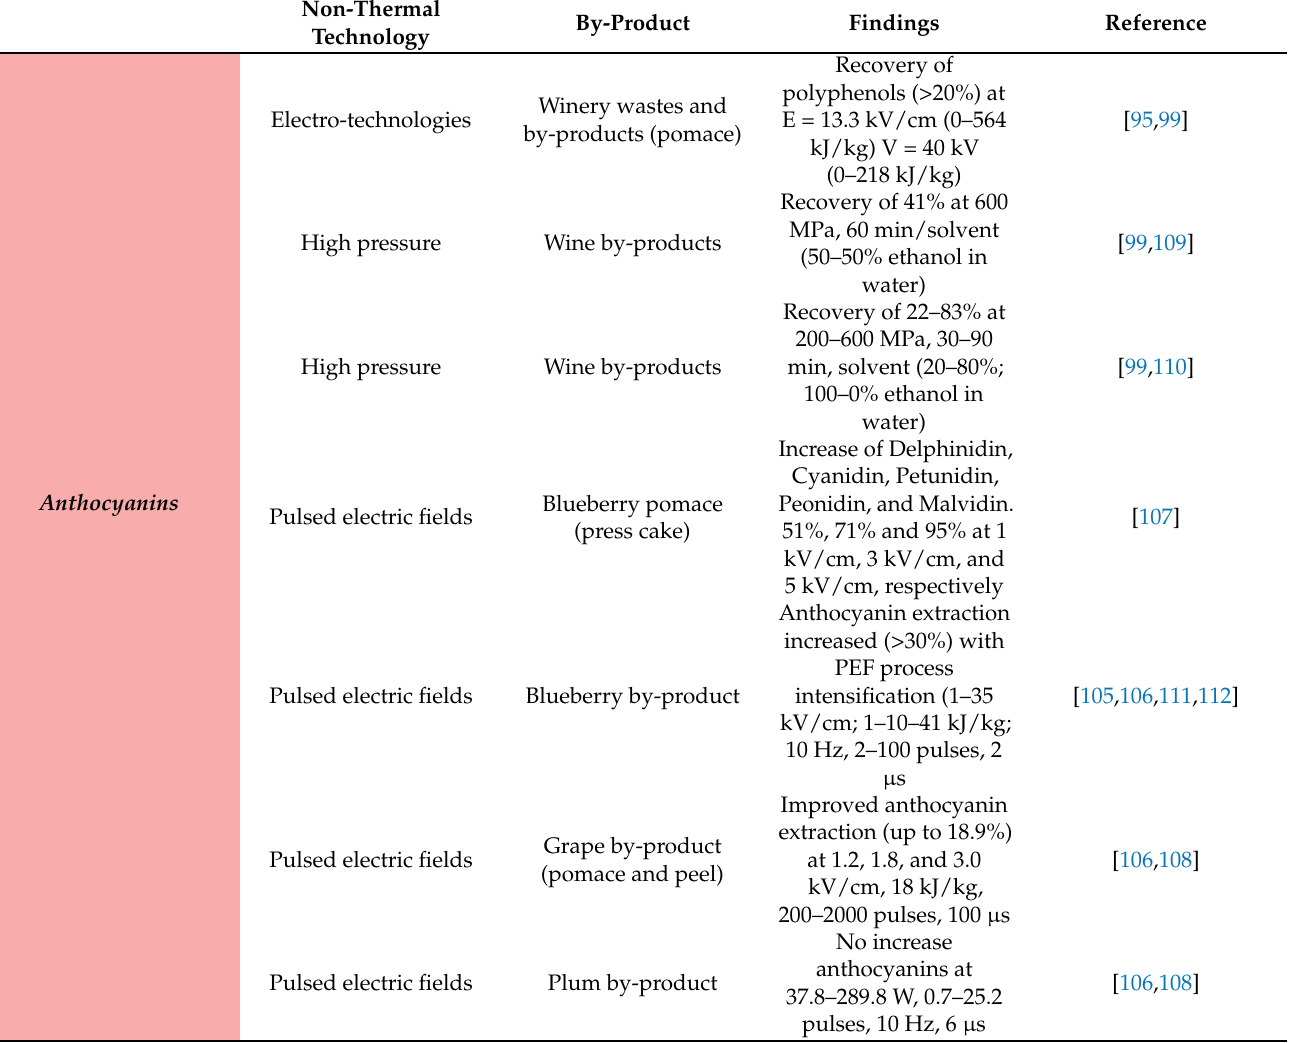
Table 2. Effect of non-thermal technologies on F&V by-products pigments (anthocyanins, betalains, carotenoids and